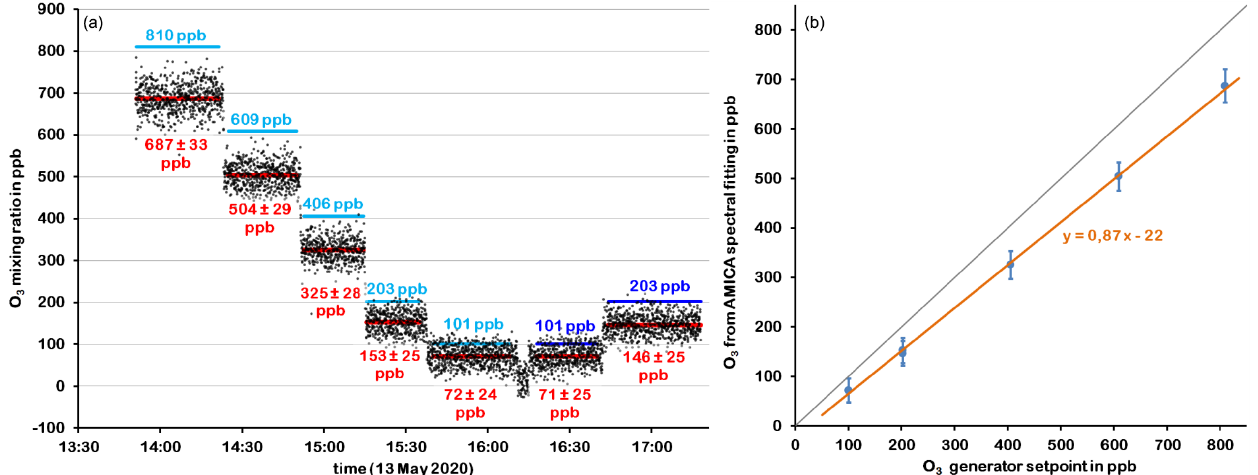
Figure 11. Panel (a) shows the O 3 mixing ratios fitted to AMICA spectra (black: individual data points; red: averaged with standard devi- ations) and the known mixing ratios in the standards (light/dark blue: with/without stainless-steel tube in transfer line; see text for details) against time of the experiment. Panel (b) shows AMICA O 3 vs. standard O 3 and a linear fit of these